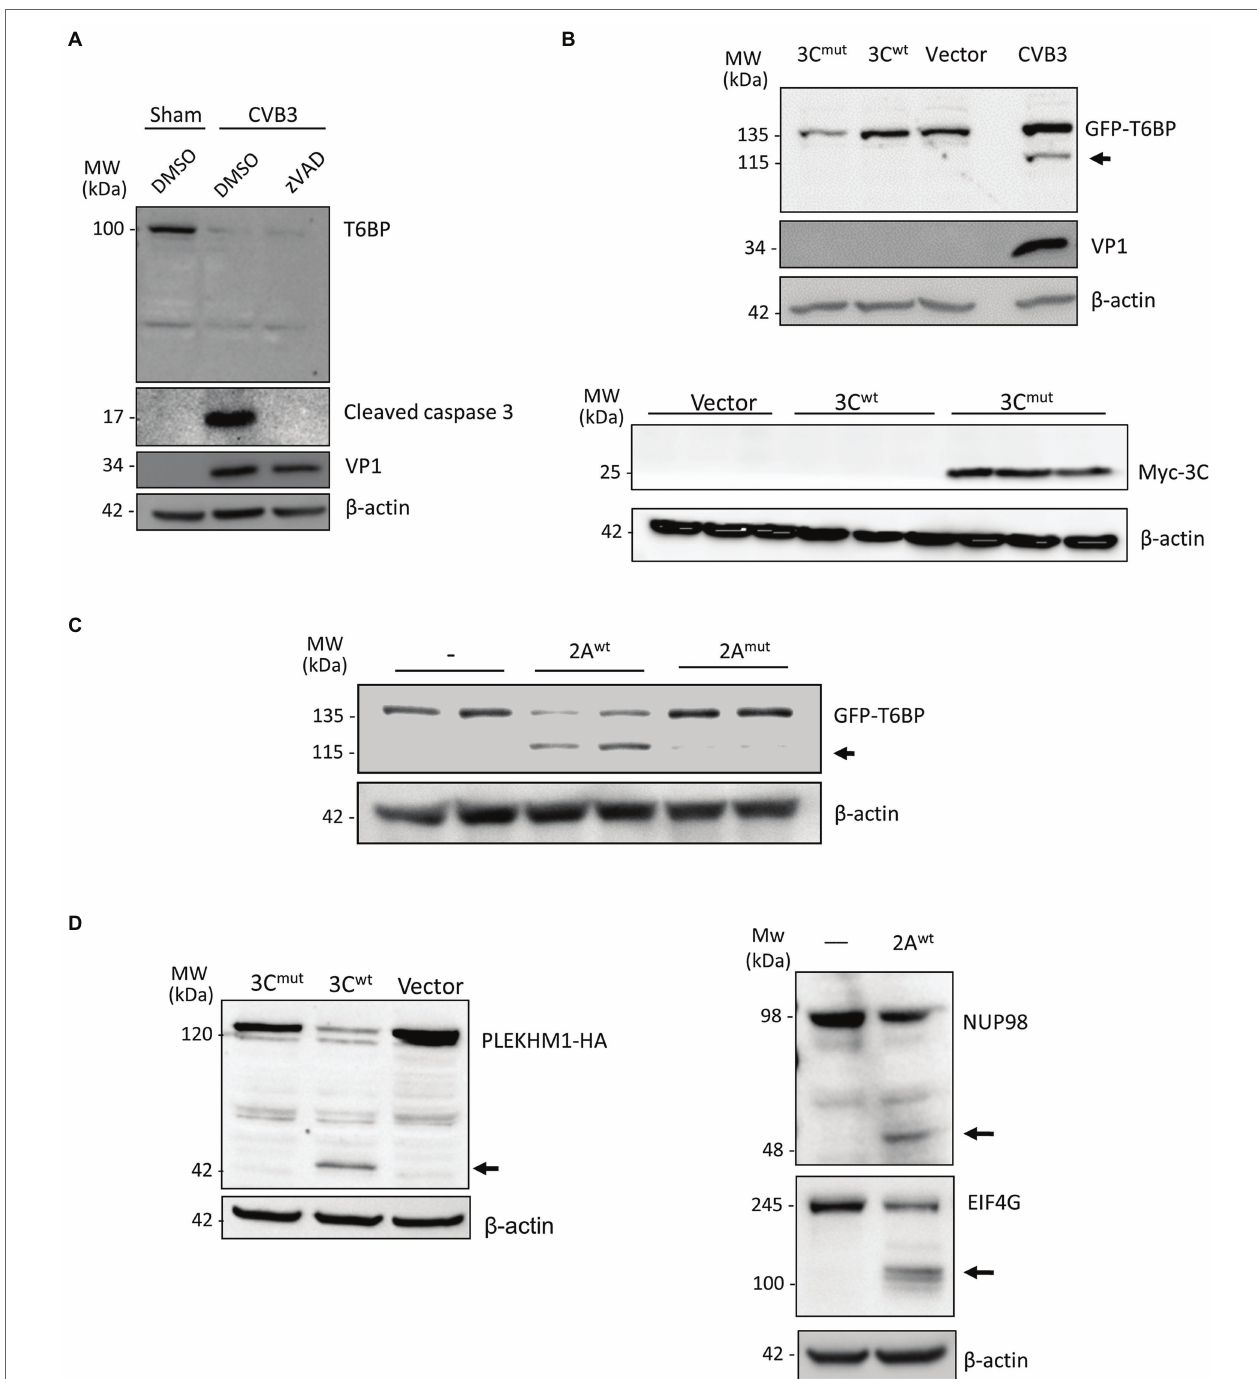
FIGURE 3 | T6BP is cleaved by 2A pro . (A) HeLa cells were infected with CVB3 (MOI = 10) for 7 h in the presence of a pan-caspase inhibitor (zVAD-FMK, 50 μ m) or vehicle control (DMSO). Western blot analysis was performed with anti-T6BP or anti-cleaved caspase 3 antibody. (B) HeLa cells were transfected with GFP-T6BP together with either catalytically inactive myc-3C mut , myc-wild-type 3C (3C wt ), or control empty vector. After 24 h, cell lysates were collected and probed with anti- GFP and VP1 antibodies (upper panel) or with anti-myc antibody (bottom panel). CVB3-infected cell lysates were used as a positive control. (C) In vitro cleavage assay was performed by incubating GFP-T6BP-expressing HeLa lysates with vehicle ( − ), purified wild-type 2A (2A wt ), or catalytically inactive 2A (C109A) mutant (2A mut ). Western blot analysis was conducted with anti-GFP antibody. Arrow denotes 2A-mediated cleavage fragment. (D) HeLa cells expressing PLEKHM1-HA together with either 3C mut , 3C wt , or control empty vector for 24 h were harvested for Western blot analysis with anti-HA antibody (left). In vitro cleavage assay was performed through incubation of purified 2A wt with HeLa lysates and analyzed by Western blot analysis with anti-NUP98 and anti-EIF4G antibodies. Black arrows denote cleavage